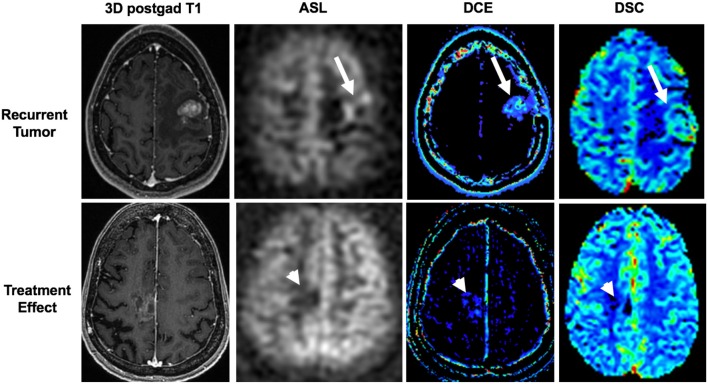
Utility of arterial spin labeling (ASL), dynamic contrast enhancement (DCE), and dynamic susceptibility contrast (DSC) perfusion MRI to differentiate between recurrent tumor and treatment effect. Top panel shows recurrent tumor in a 34-years-old female with a left frontal breast cancer metastasis that was previously resected and treated with stereotactic radiosurgery. ASL, DCE, and DSC images demonstrate high cerebral blood flow, Ktrans, and cerebral blood volume (arrows), respectively, associated with the contrast-enhancing lesion. Tumor was confirmed on histopathology from subsequent re-resection. Bottom panel shows treatment effect in a 65-years-old female with a right frontal lung cancer metastasis who was previously resected and treated with stereotactic radiosurgery. ASL, DCE, and DSC images demonstrate low cerebral blood flow, Ktrans, and cerebral blood volume (arrowheads), respectively, associated with the mildly enhancing lesion. Treatment effect was confirmed with negative PET/MRI (not shown) and a stable 3-months follow-up MRI (not shown).